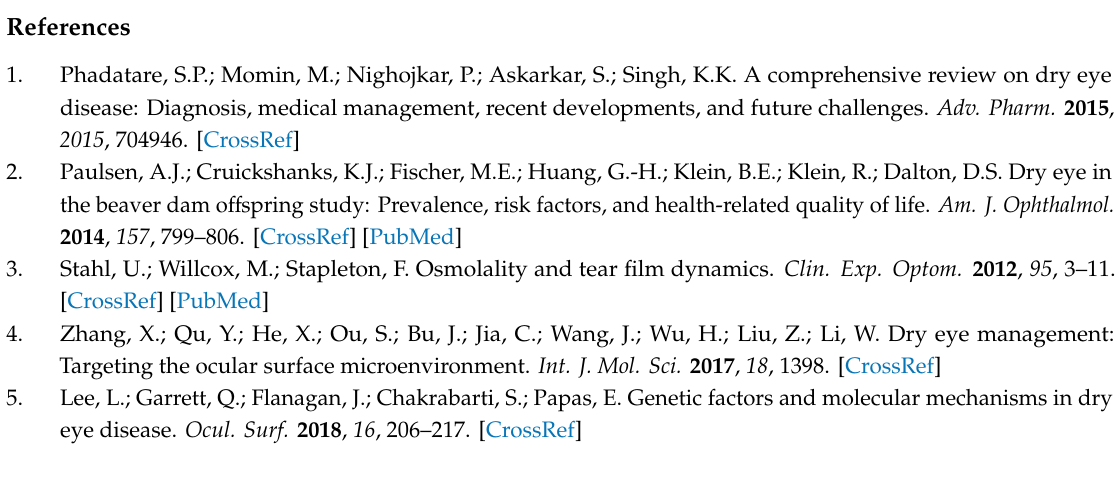
Figure S1: The Inflammatory signaling (MAPK) were analyzed by western blot (WB) for supplementary data Figure